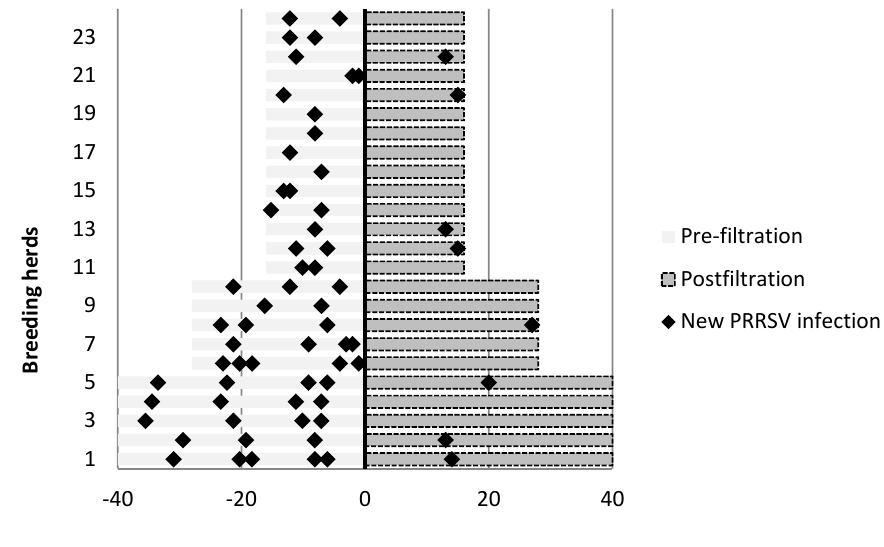
Figure 1. New porcine reproductive and respiratory syndrome virus (PRRSV) infections in breeding herds before and after the implementation of air filtration.